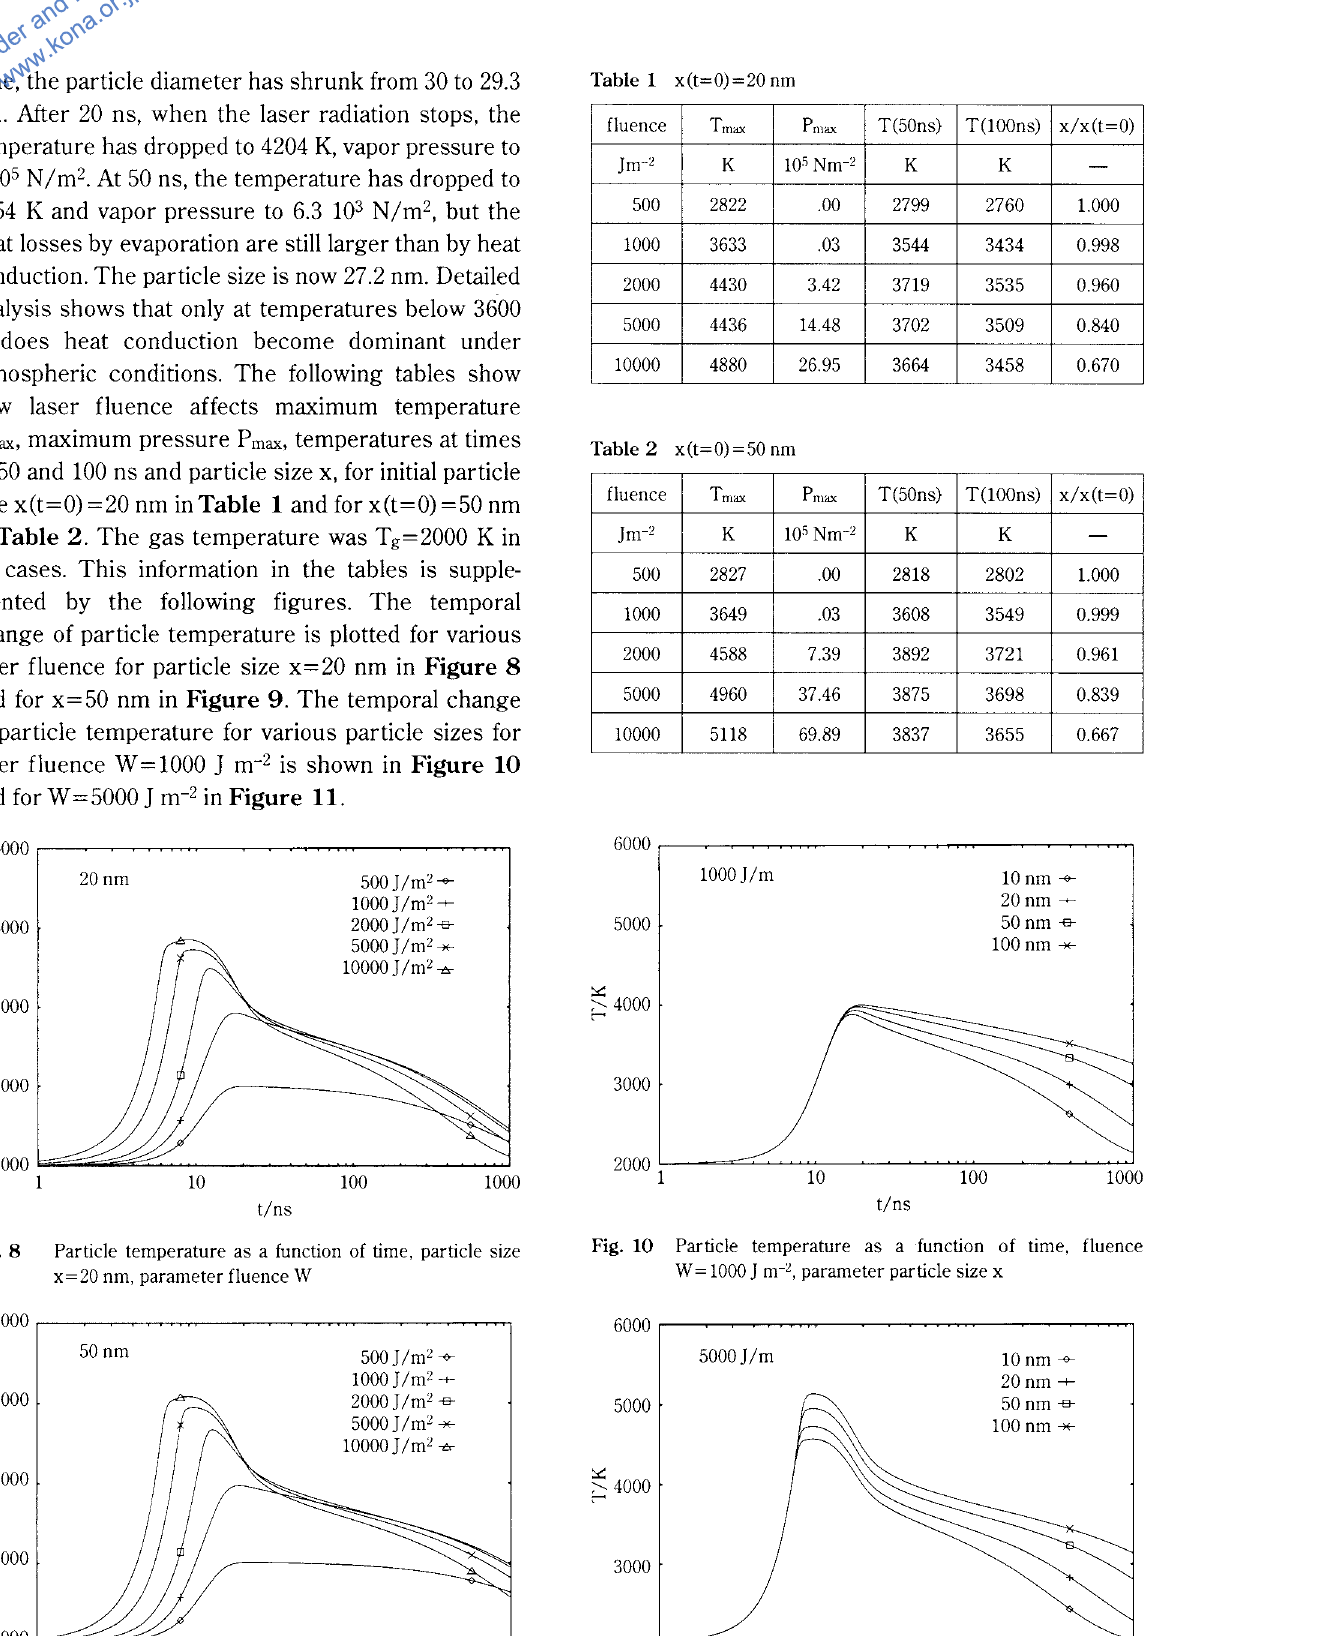
Fig. 9 Particle temperature as a function of time, particle size x=50 nm, parameter fluence W